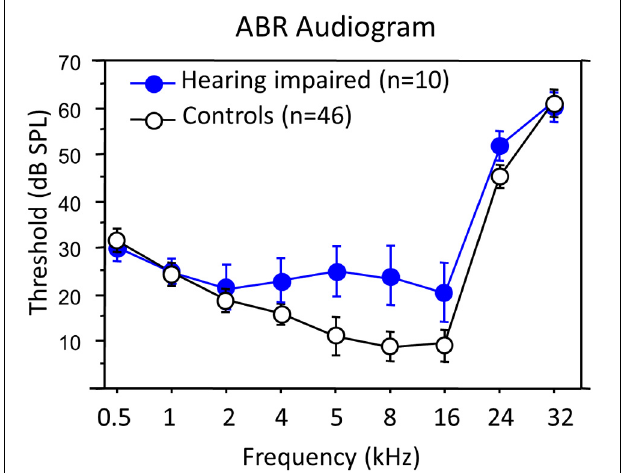
FIGURE 1 | Average audiogram of hearing impaired animals as compared to control animals. Blue dots represent the averaged threshold of the ABR audiogram of the animals ( n = 10) included in this study, and the error bars indicate the standard error of the mean. White dots are computed from a database of ABRs obtained in control guinea pigs ( n = 46) of similar age and